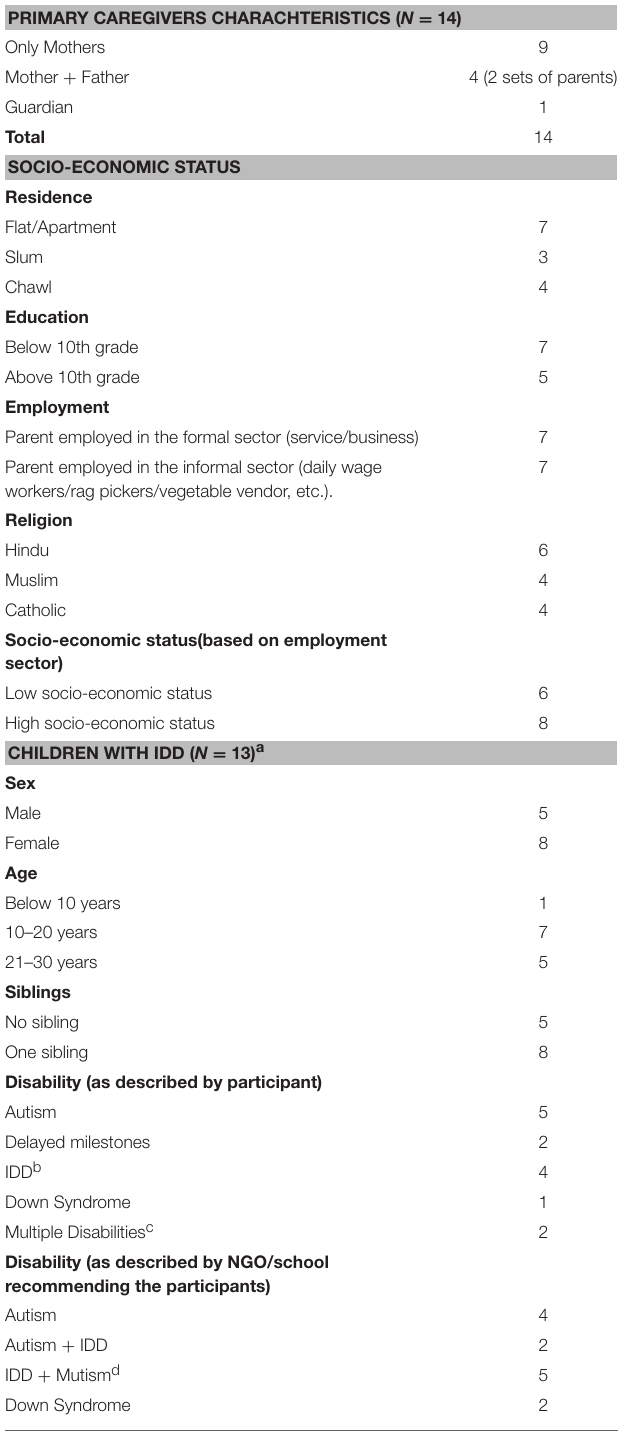
TABLE 1 | Parent and child socio-economic and demographic